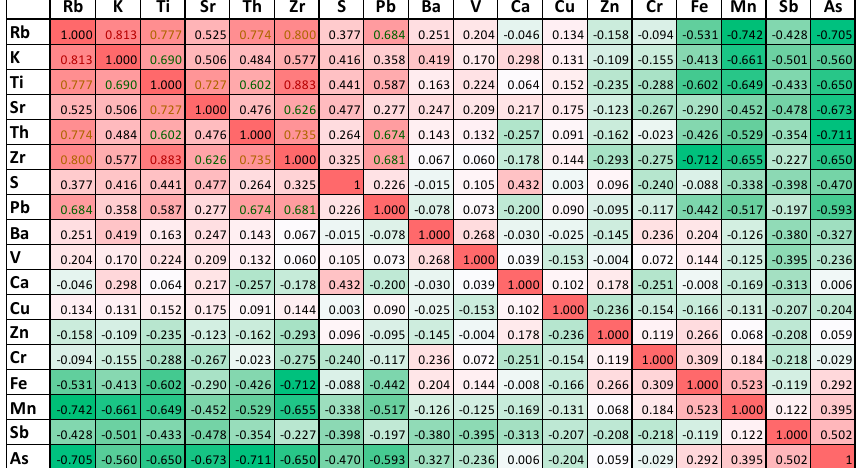
Figure 5. Cochran’s C test. Samples from B horizon, pXRF data. The C test detects one exceptionally large variance value at a time. To reduce compositional data bias, we examined element relationships through PCA. The correlation matrix was used, 18 eigenvalues were calculated and graphs were selected from six eigenvectors. Rotation was not applied. An Sb-As-Mn association appears more clearly for Factor F3 (Figure 6 and Table 2).